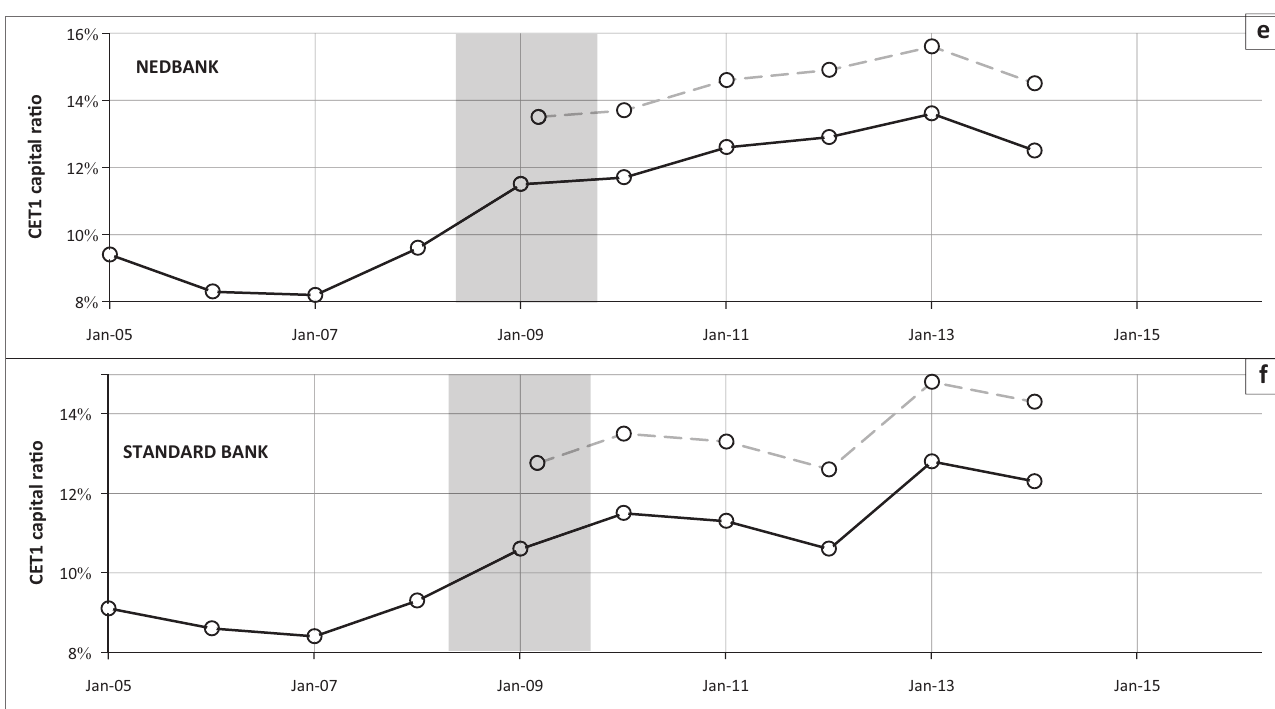
Note: The shaded area represents the fall in the market because of the 2007 credit crisis and illustrates that the simulated contingent convertible triggers could have produced a common equity tier 1 capital injection during this period, for all four banks. FNB, First National Bank; ABSA, Amalgamated Banks of South Africa. FIGURE 11 (Continues...): The conversion of proposed contingent convertible instruments of South African banks (a–f) during an economic